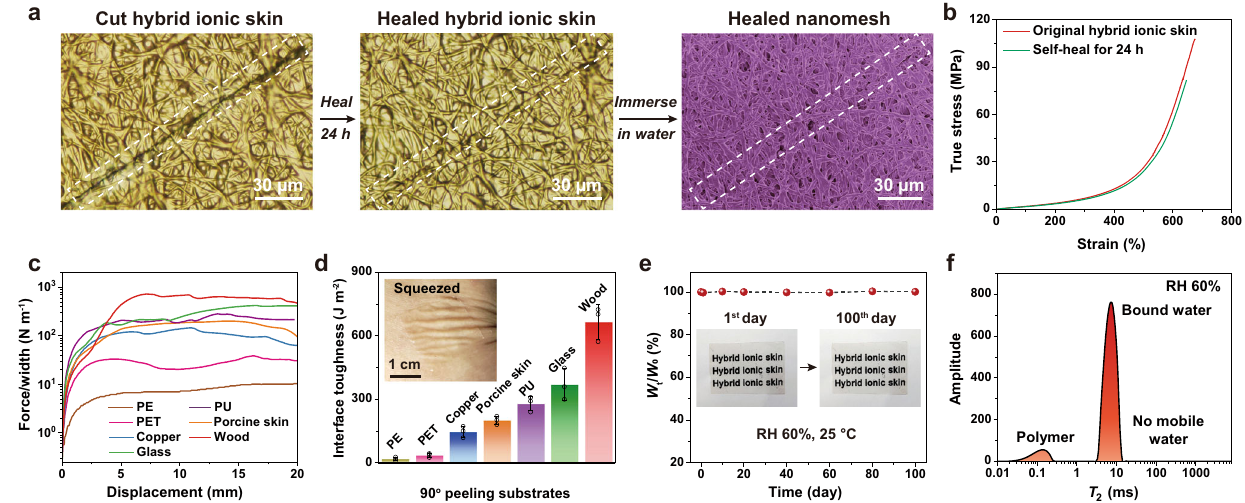
Fig. 3 | Self-healability, adhesion, and environmental stability of hybrid ionic skin.a OpticalmicrographsofacuthybridionicskinbeforeandafterhealingatRH 80%for24h,andSEMimageofhealednanomeshscaffoldafterwashingawayionic matrix. b Truestress – straincurvesoftheoriginalandself-healedhybridionicskins. c Measured peeling forces per width of hybrid ionic skin adhered on various